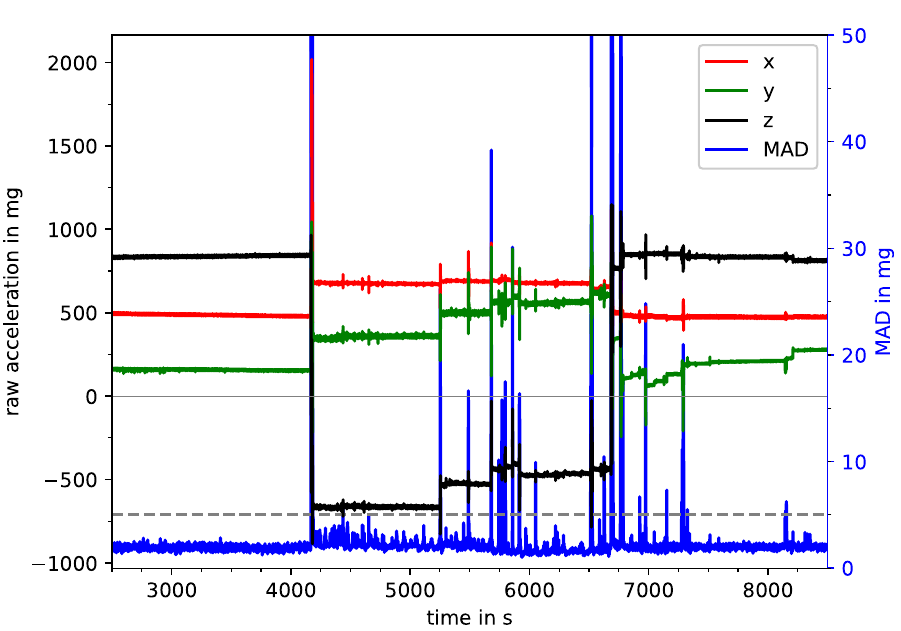
Fig 2. Raw acceleration signals and MAD. A typical nocturnal 100 minute part of the raw data is shown with all three directions ( € x —red, € y —green, € z —black) of the acceleration signal according to the left vertical axis. Furthermore, one- second mean amplitude deviation (MAD) values are plotted in blue with the MAD threshold of 5 mg shown as dashed gray line according to the right vertical axis. Time periods in which the MAD 1s values are above this threshold were labeled as a position change (i.e., change in wrist orientation, see for example the peak at 4150 s).